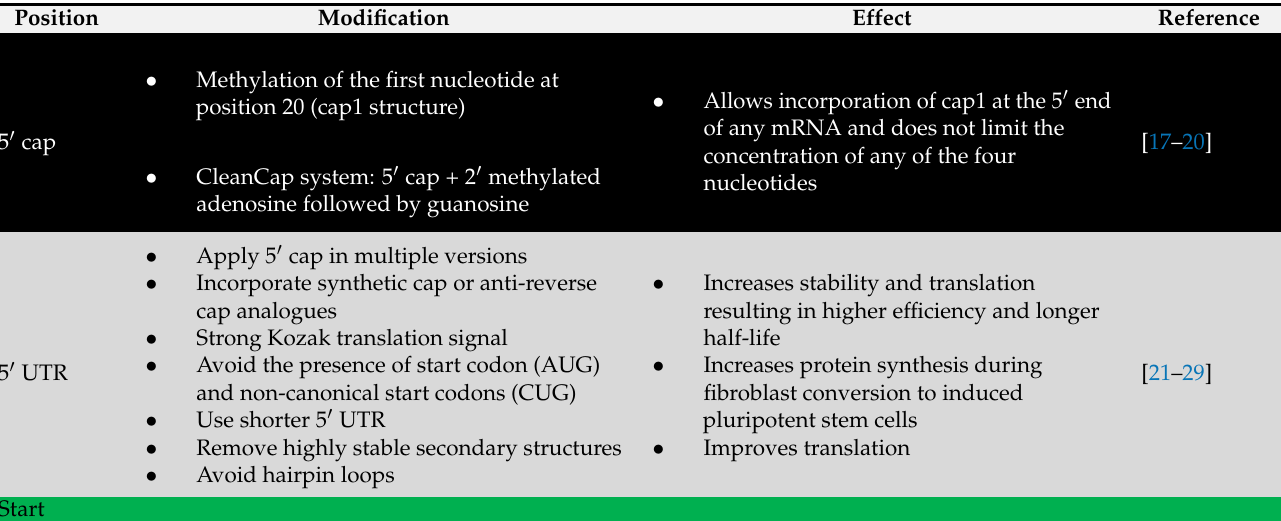
Table 2. Possible modifications of the mRNA molecule for use as COVID-19 vaccines with the spike protein of SARS-CoV-2 as target antigen. Most modifications used for approved vaccines are proprietary and therefore not publicly